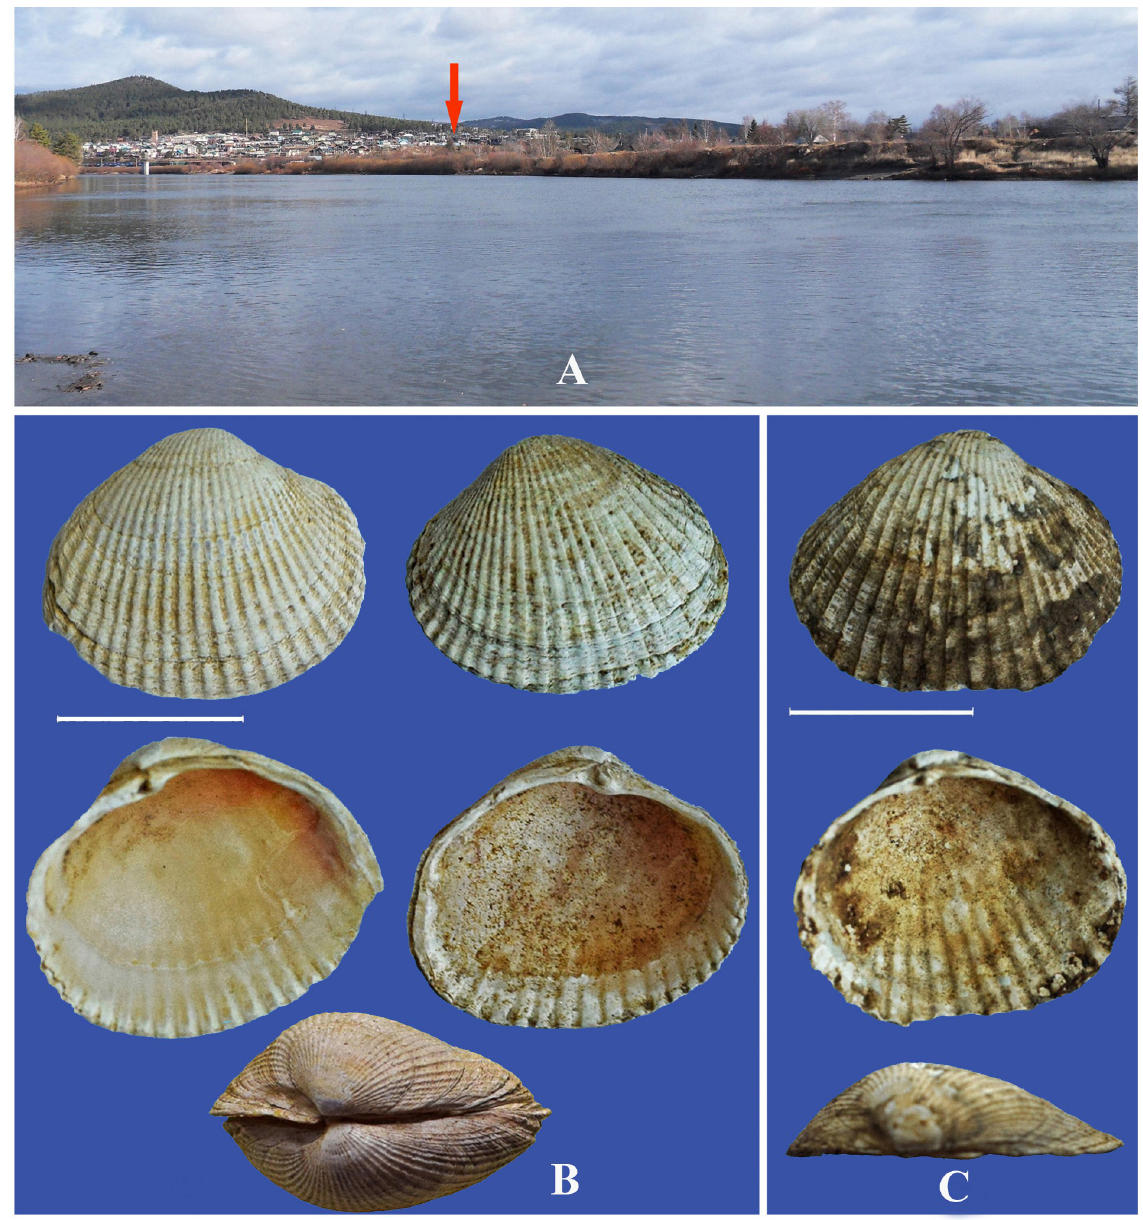
Fig 8. Locations of Monodacna species. A–Ingoda River near Antipikha settlement, suburb of Chita city. Fossil shells (Outside, inside and dorsal views) from drill hole in the Ingoda River flood plain: B– Monodacna cf. polymorpha , C– Monodacna cf. colorata . Scale bar 1 cm.